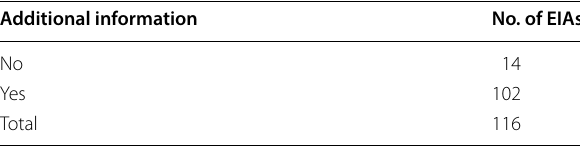
Table 13 Supply of additional